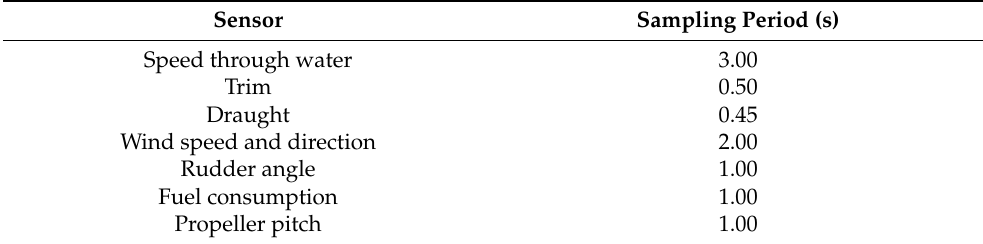
Table 2. Sampling period of diverse